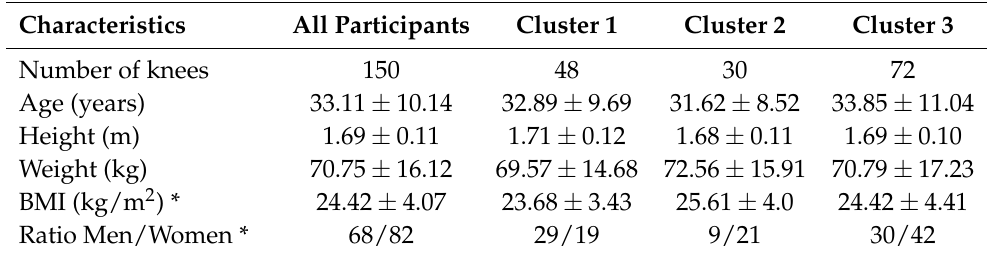
Table 3. Between-cluster differences on the demographic characteristics of the participants (units ±